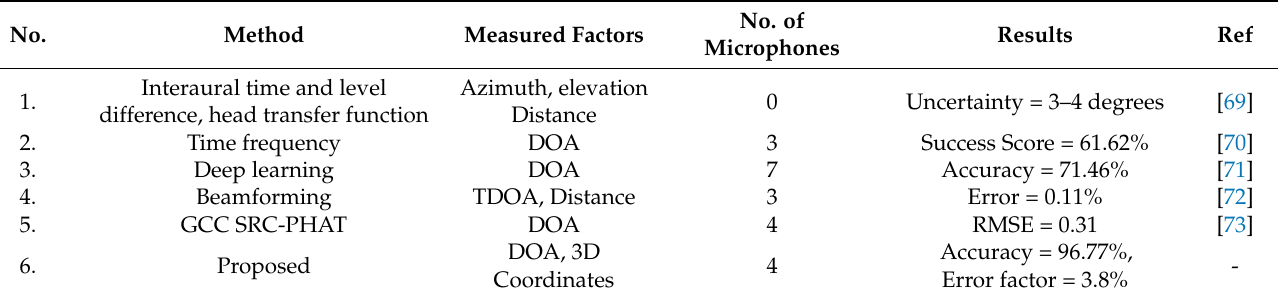
Table 2. Results